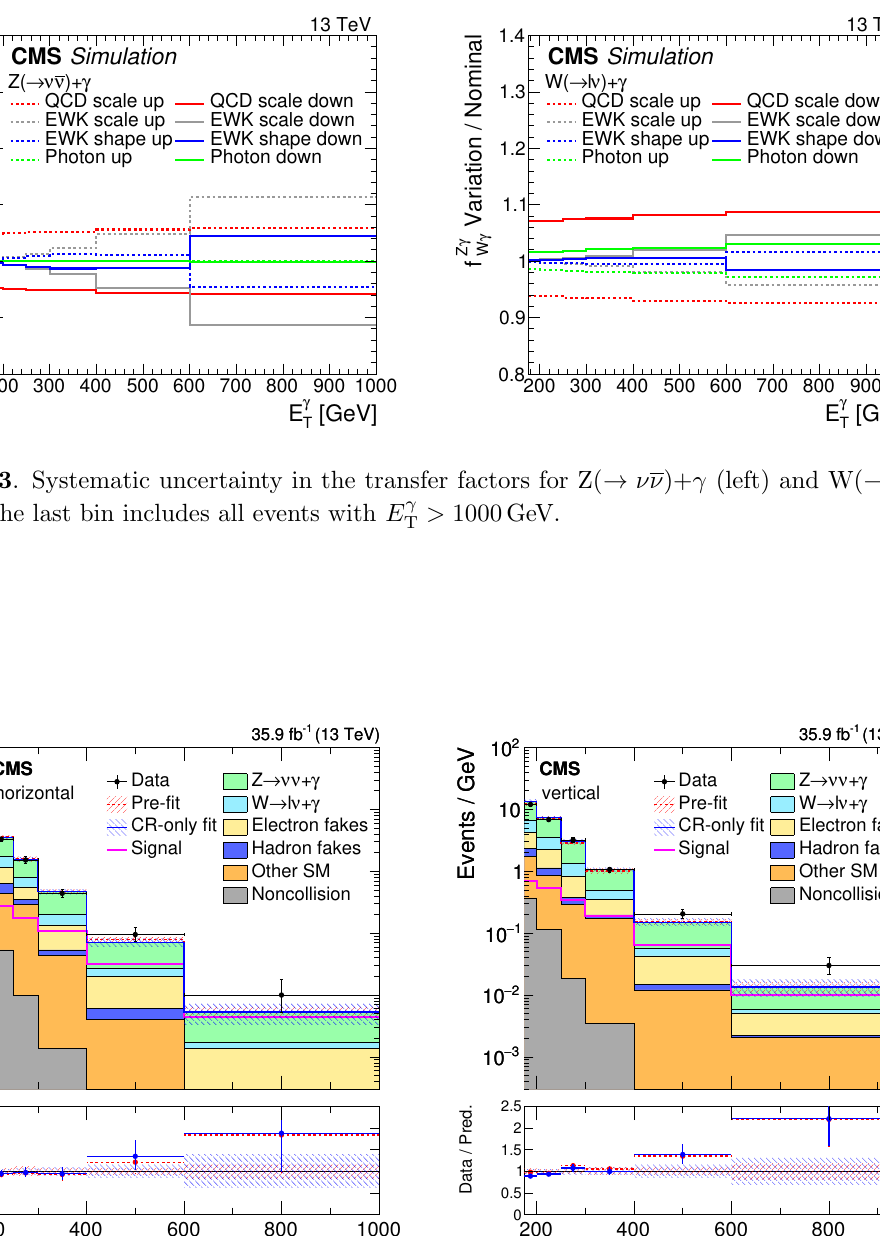
Figure 14 . Observed E (cid:13) distribution in the horizontal (left) and vertical (right) signal regions T compared with the post-(cid:12)t background expectations for various SM processes. The last bin in- cludes all events with E (cid:13) > 1000 GeV. The expected background distributions are evaluated after T performing a combined (cid:12)t to the data in all the control samples, not including the signal region.